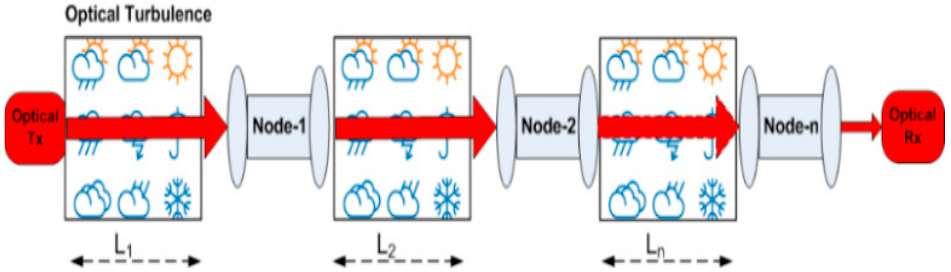
Figure 15. The optical relaying networks in FSO composed of nodes at the spacing of Li.